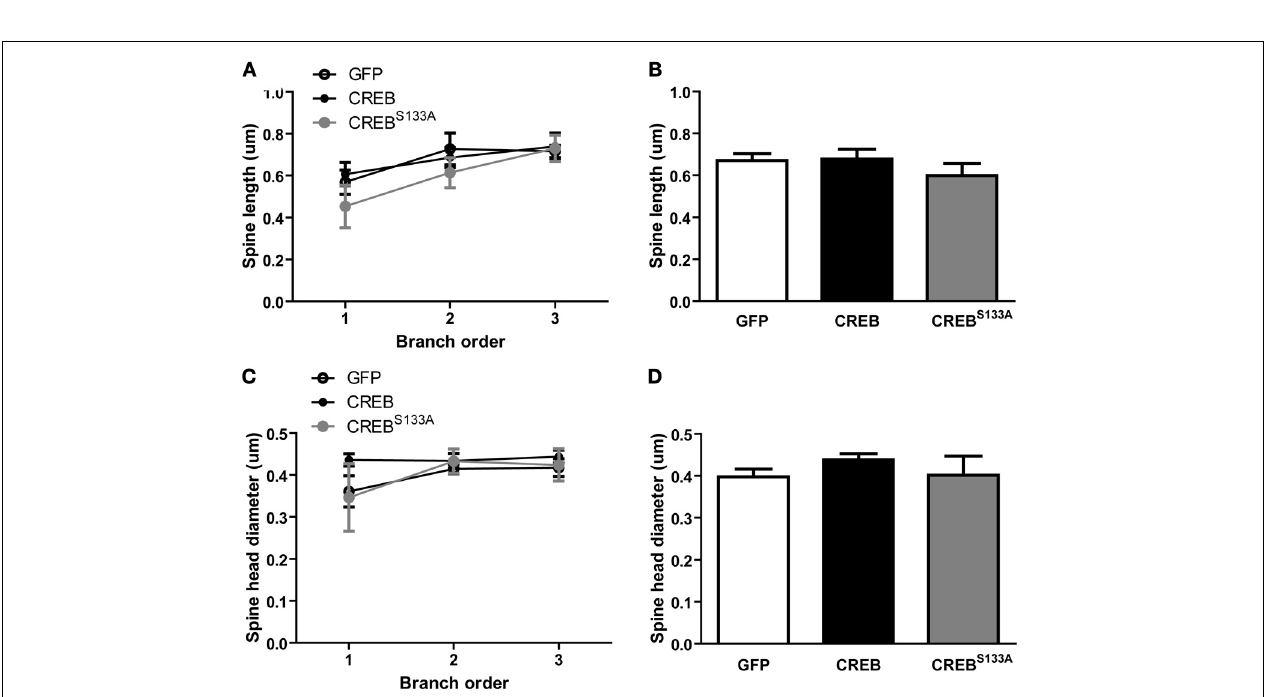
FIGURE 3 | CREB does not affect dendritic length and volume. (A) Dendritic length per branch order and (B) across all branches was comparable between LA neurons overexpressing GFP ( n = 7), CREB ( n = 6), or